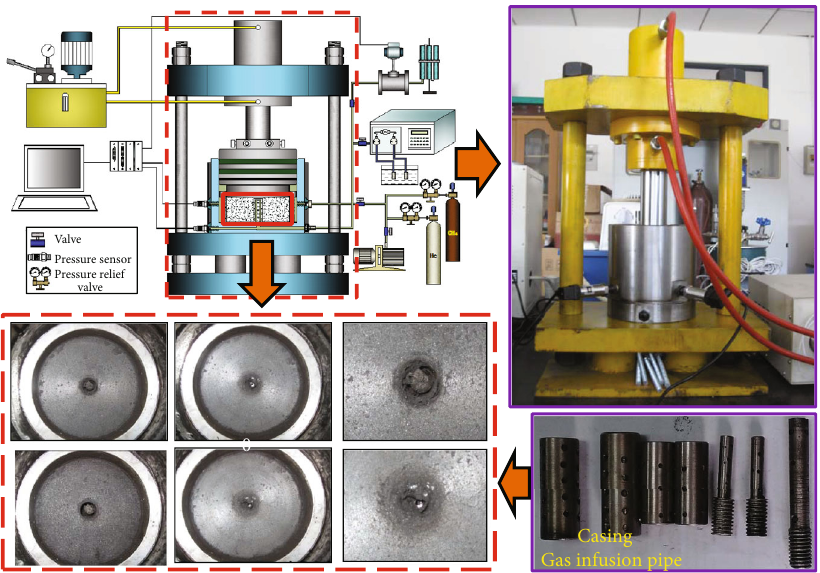
Figure 3: Experimental apparatus and deformation characteristics of coal around the boreholes of di ff erent